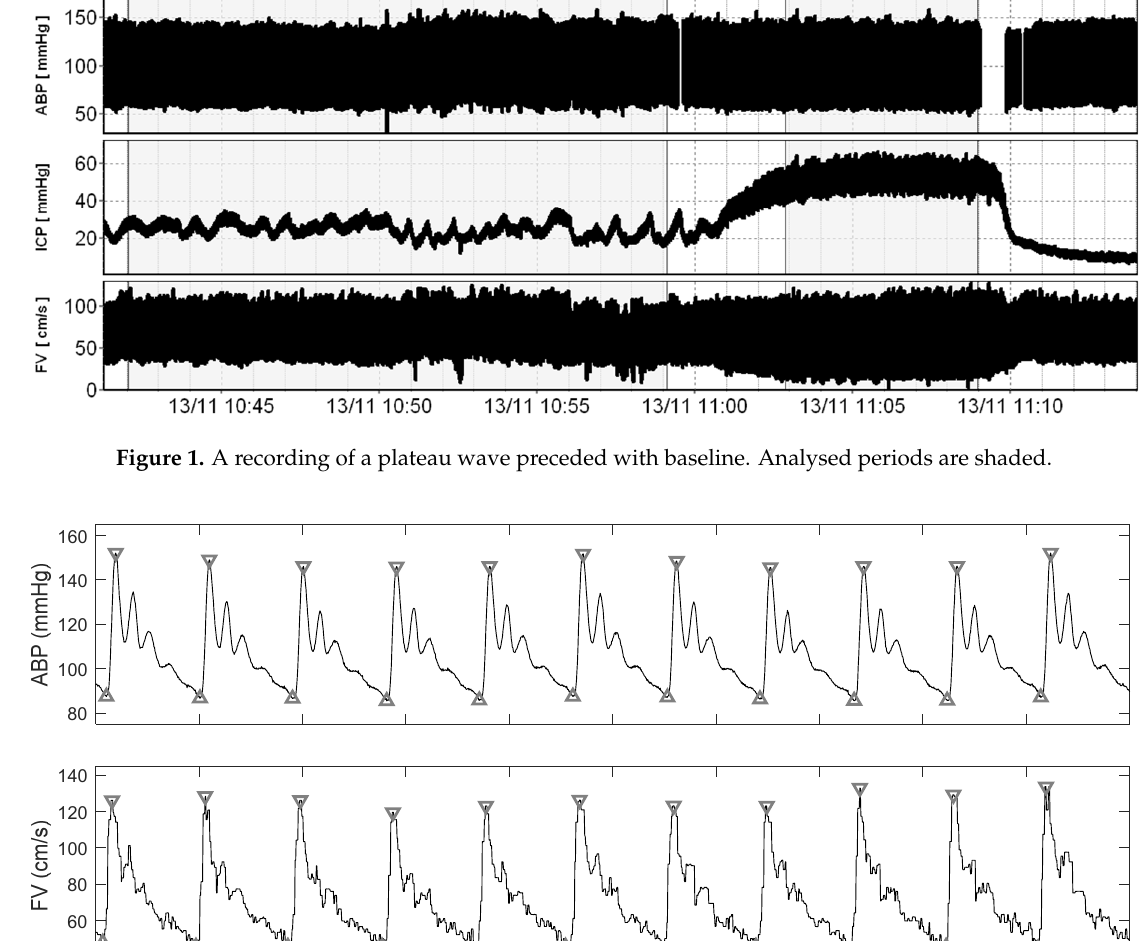
(cid:113) (cid:104) ( ABP − FV ) 2 (cid:105) ,DI rsq = t t t t